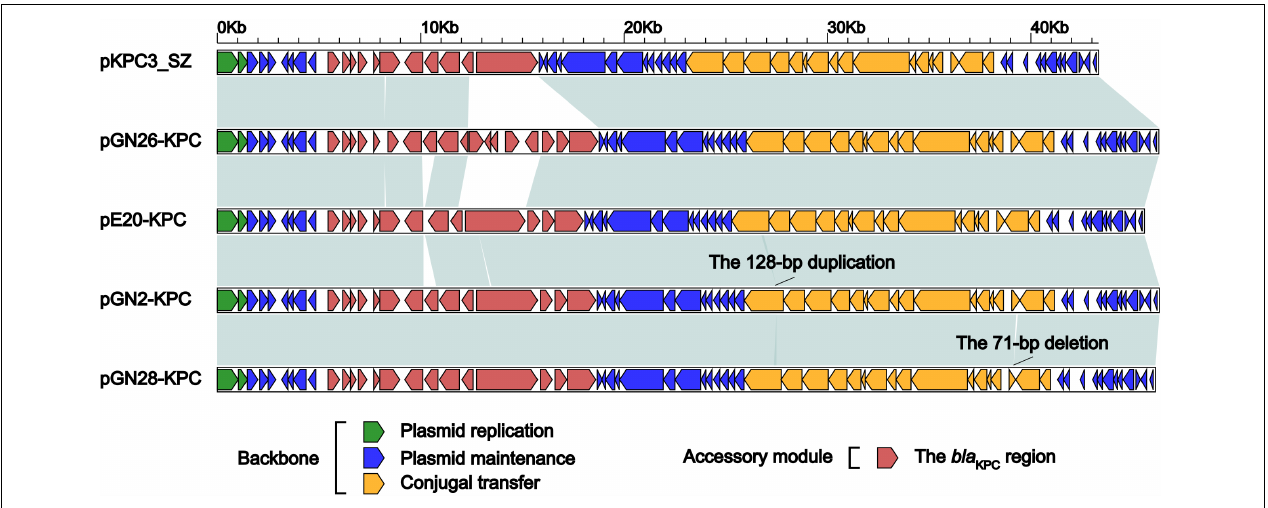
FIGURE 1 | Linear comparison of IncX6 plasmids. Genes are denoted by arrows. Genes, mobile elements and other features are colored based on function classification. Shading denotes regions of homology ( > 95% nucleotide identity).